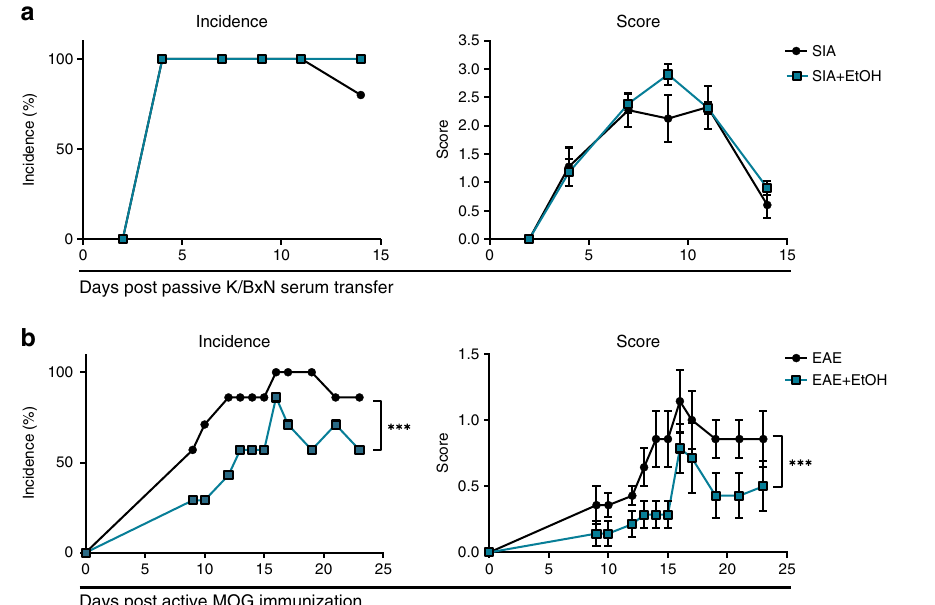
Fig. 2 Alcohol inhibits active but not effector models of autoimmune in fl ammatory disease. a Incidence and clinical score of mice with K/BxN serum induced arthritis (SIA) exposed to vehicle (SIA n = 5 mice) or alcohol (SIA + EtOH, n = 10 mice). b Incidence and clinical score of experimental autoimmune encephalomyelitis (EAE) exposed to vehicle (EAE, n = 7 mice) or alcohol (EAE + EtOH, n = 7 mice). N number represents number of animals used per experiment. Data shown from one of three independent experiments and expressed as mean ± SD. Statistical difference was determined by two- way ANOVA. * p < 0.05; ** p < 0.01; *** p < 0.001.